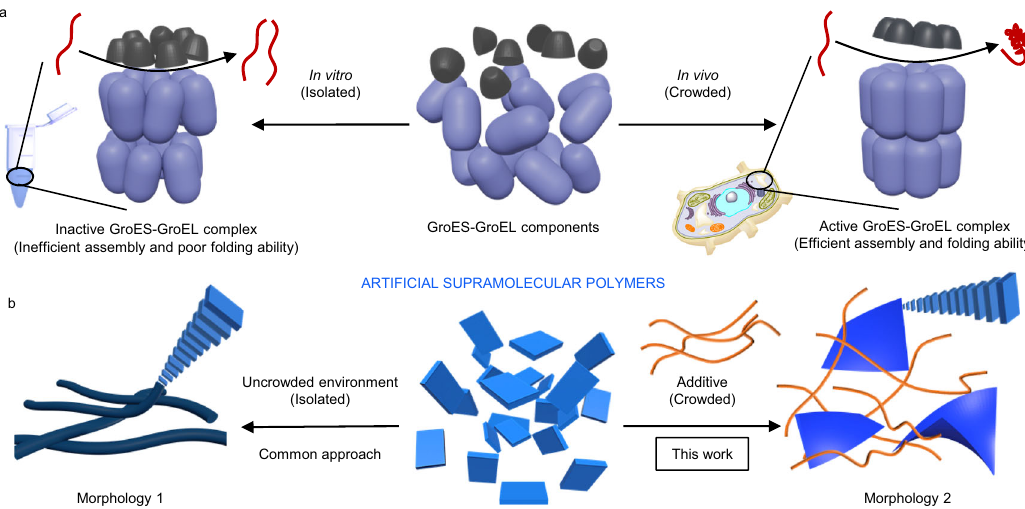
Fig. 1 | Conceptual representation of crowding effects in biological and arti fi - cial systems. a schematic representation of the GroES-GroEL complex assembled from21individualcomponents(middle)invitro(left)andinvivo(right),highlighting